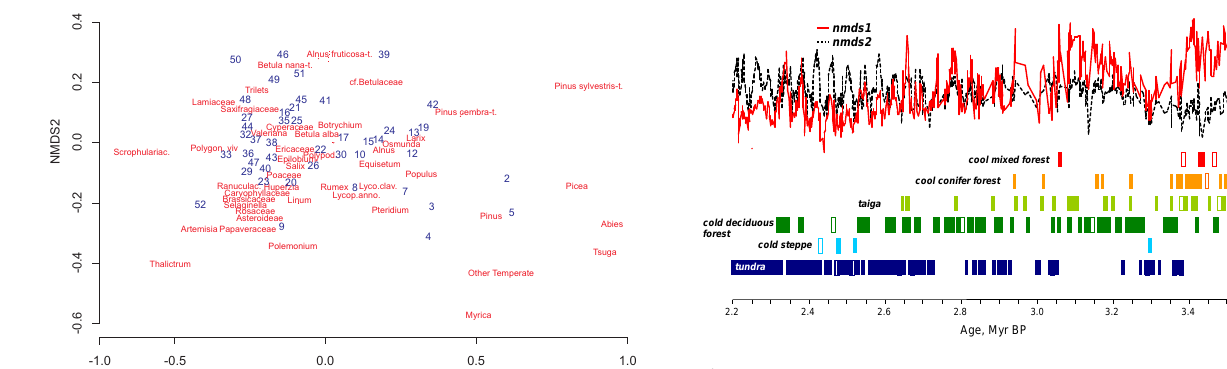
Figure 6. Pollen-based biome reconstruction showing changes in the dominant vegetation type around Lake El’gygytgyn between ca. 3.58 and 2.15Myr BP. Open squares indicate the biome reconstruc- tion derived from the spectra with low pollen content (i.e., less than 100 terrestrial pollen grains, for details see Tarasov et al.,